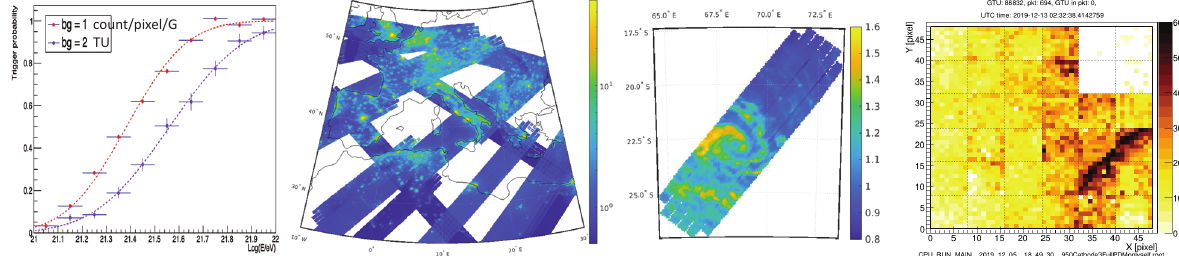
Figure 8. Left: trigger e ffi ciency of MINI-EUSO as a function of energy. Center left: UV map of the nightly Earth (the bands correspond to di ff erent passages of the ISS with the instrument turned on by the cosmonauts). Center right: UV map of a cyclone. Right: ring of an ELVES (with apparent luminal motion in the field of